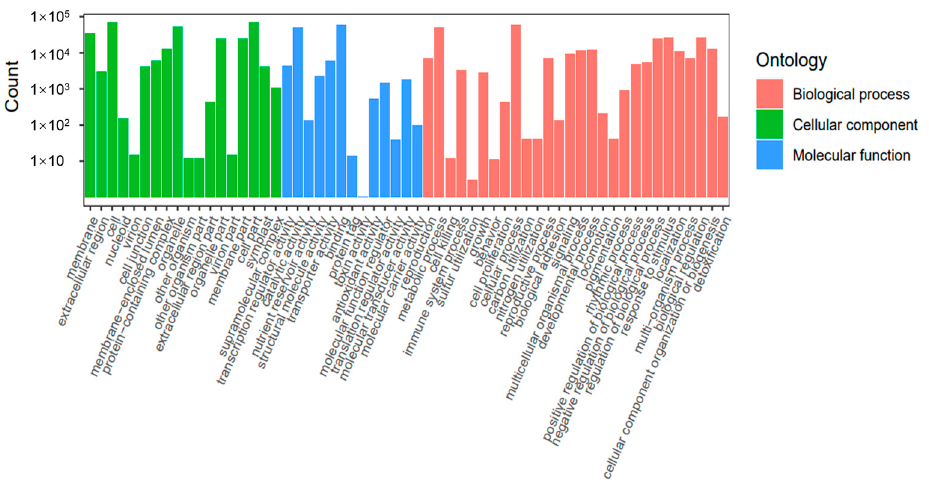
Figure 4. Gene ontology (GO) classification of unigenes.